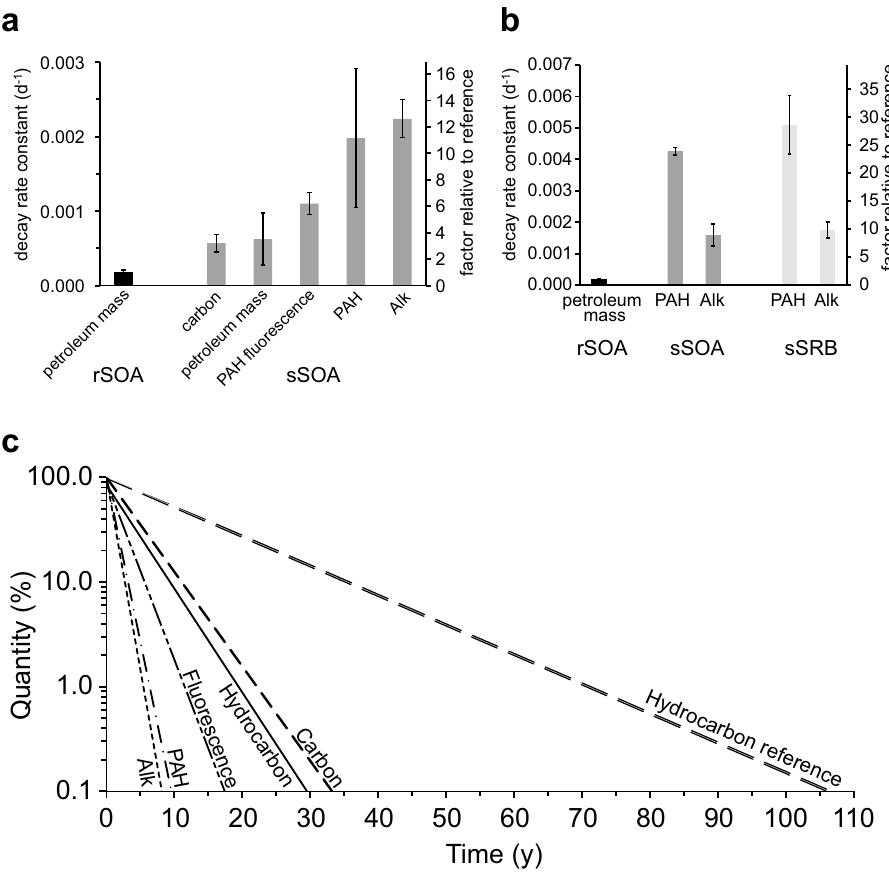
Figure 6. Summary of decay rates and projections. ( a ) Decay rates of rSOAs and sSOAs. The factor relative to reference relates the decay rates to the mass loss rate of the reference rSOA kept in the dark at constant temperature. Error bars depict standard error. ( b ) Decay rates of rSOAs, sSOAs and sSRBs during the first 9 months for which sSRB data are available. ( c ) Projections of petroleum hydrocarbon decomposition in sSOAs based on the decay rate constants determined in our study. Lines depict percent quantity remaining versus time. sSOA carbon content decreases slower than sSOA petroleum hydrocarbon mass (which includes oxyhydrocarbons) because small amounts of inorganic carbon may be contained in the sSOAs. Fluorescence decays slower than the GC/MS amenable PAHs as some oxidized PAHs retain fluorescence. Petroleum hydrocarbon mass in the reference rSOAs kept in the dark at constant temperature decays slower because the rSOAs were not exposed to the complex microbial community in the beach sand and the sedimentary environmental